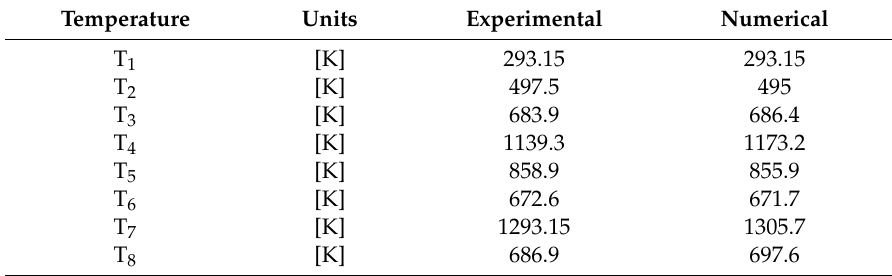
Table 3. Comparison between experimental and numerical results of temperatures values.